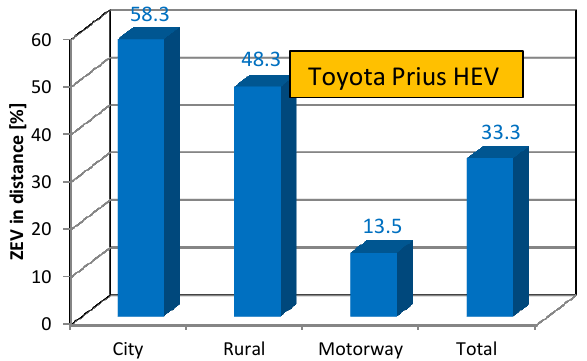
Fig. 3. Proportion of the drive with the combustion engine switched off (ZEV – Zero Emission Vehicle) in relation to the distance traveled in the Real Driving Emissions (RDE) test phases (Toyota Prius HEV)